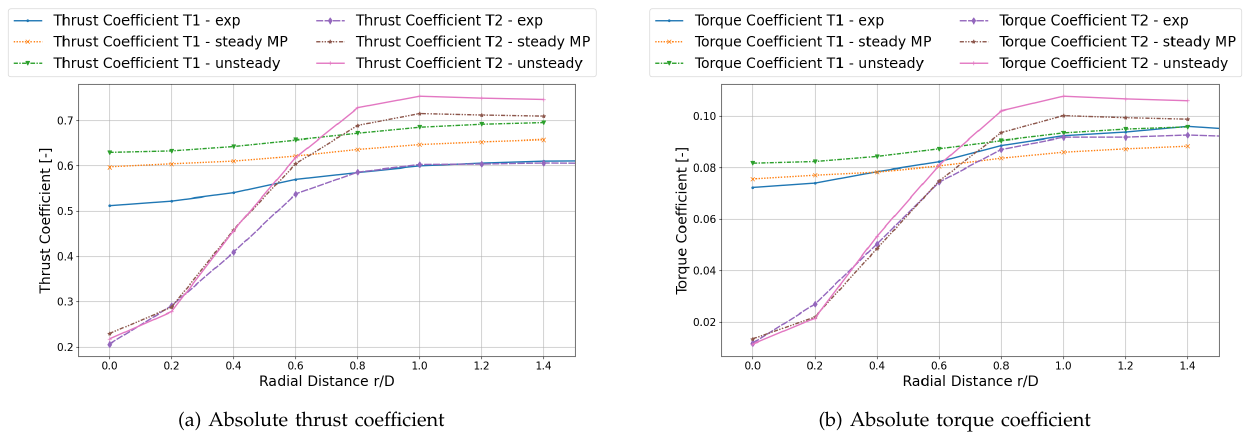
Fig. 7. Absolute thrust and torque coefficient of experiment and simulations. T1: upstream turbine. T2: downstream turbine. exp: experimental data. steady MP: steady state simulation with mixing plane interface. unsteady: unsteady simulation.